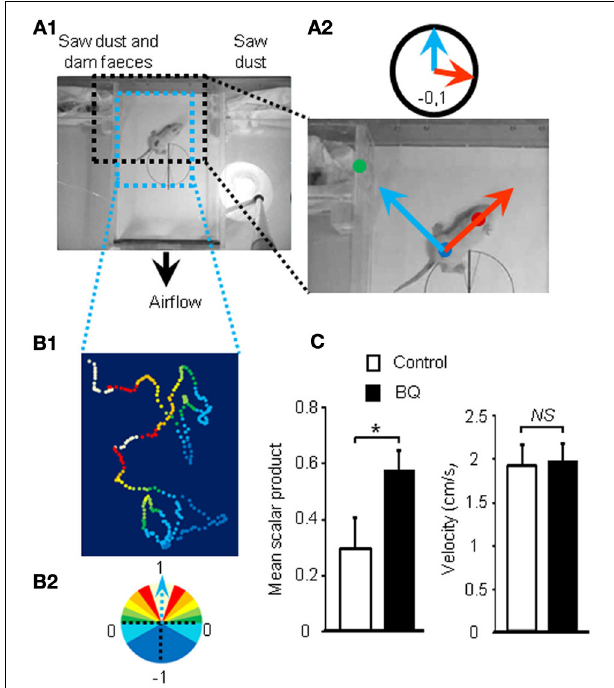
FIGURE 2 | Improvement of olfactory performances after 10 days of endothelin receptor antagonists treatment. (A 1 ) Pups were placed in the center of a box with a continuous flow of incoming air from two different compartments. (A 2 ) Scalar products of two vectors were calculated to score the orientation of the animal toward the dam odor source. (B 1 ) Representative path and orientation of a pup’s head position during a 1min trial. Colored dots represent head position in the box and orientation toward the odor source, ranging from white to dark blue, from full orientation to opposite orientation toward dam odor source, i.e., 1 to − 1 scalar product, respectively (B 2 ) . (C) Mean scalar product and mean of velocity values ( ± s.e.m.) of pups treated with BQ or vehicle ( n = 12; ∗ P < 0 .